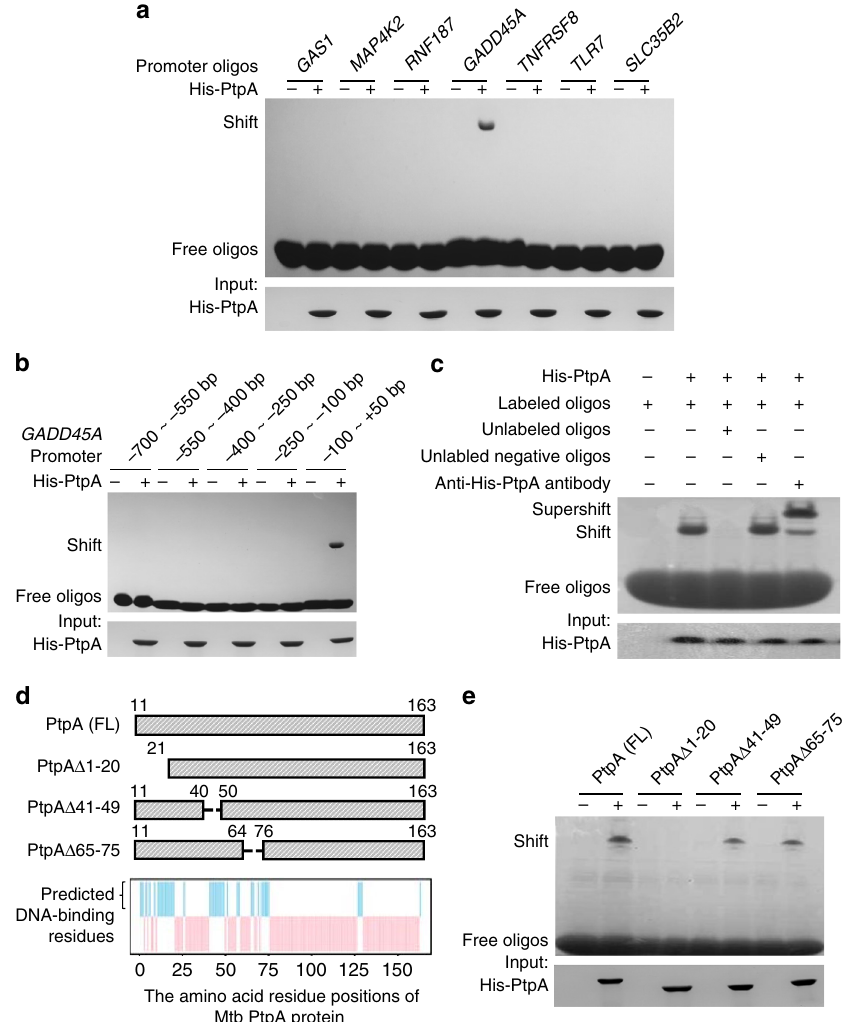
Fig. 5 Identi fi cation of the DNA-binding region of potential target genes by PtpA. a EMSA analysis of interactions between His-tagged Mtb PtpA and its potential targeting gene promoters. The promoters of seven genes (10 nM) were ampli fi ed and incubated with 10 μ g of puri fi ed His-PtpA. b EMSA analysis of interactions between His-tagged PtpA and fi ve promoter fragments of GADD45A . The promoter fragments of GADD45A (10 nM) were ampli fi ed and incubated with 10 μ g of puri fi ed His-PtpA. c Competitive EMSA analysis of speci fi c interactions between PtpA and the promoter fragment of GADD45A ( − 100 bp to + 50 bp). Biotinylated oligos ( − 100 bp to + 50 bp) was used to determine their interactions with puri fi ed 10 μ g His-tagged PtpA protein. Unlabeled positive ( − 100 bp to + 50 bp) and negative oligos ( − 250 bp ~ − 100 bp) were added in lane 3 or 4 as speci fi c competitor sequences. Lane 5 displayed a super-shift in the presence of anti-His-PtpA antibody. d The amino acid residue positions of Mtb PtpA potentially involved in interactions with DNA were predicted by DP-bind ( blue bars ). Top , schematic representation of PtpA deletion constructs used for EMSA analysis in e . FL , full-length. e EMSA analysis of interactions between Mtb PtpA proteins and its targeting promoter fragment ( − 100 bp to + 50 bp from the TSS of GADD45A ). The biotinylated oligos were incubated with 10 μ g of puri fi ed full-length or truncated Mtb PtpA proteins. Full blots are shown in Supplementary Fig.